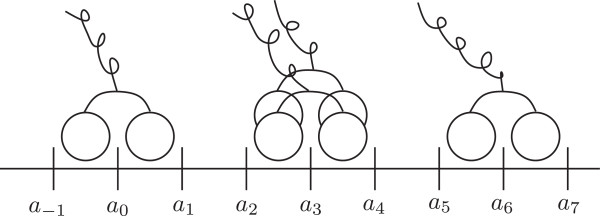
Schematic representation of the configuration of an ensemble of motors. The microtubule is represented as a bi-infinite filament with equally spaced location {…,a−1,a0,a1,…a7,…}. The rear-guard motor is engaged at location a0, two are engaged in configuration a3 and a fourth one is engage at location a6.